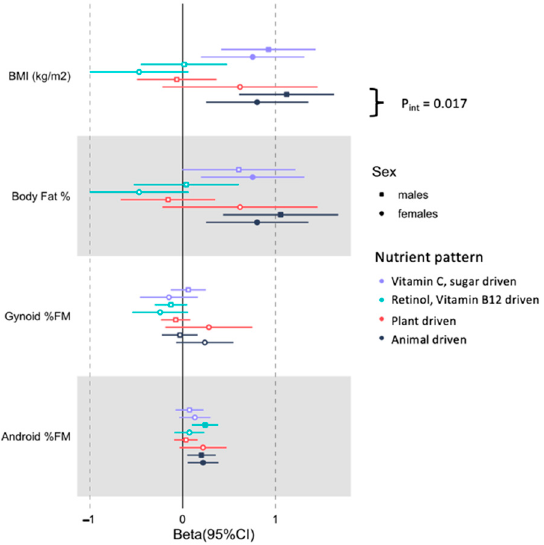
Figure 3. Stratified associations of total and regional adiposity with nutrient patterns in middle-aged black SA men and women. The associations are adjusted for age, number of steps, education status, SES status and energy intake reporting. A significant interaction between sex and animal-driven nutrient pattern on BMI was noted (P int = 0.017). Non-significant effect sizes are indicated as hollow. The Vitamin C, sugar and potassium driven nutrient pattern was positively associated with BMI and body fat% in the combined sample (Table 3). The retinol and vitamin